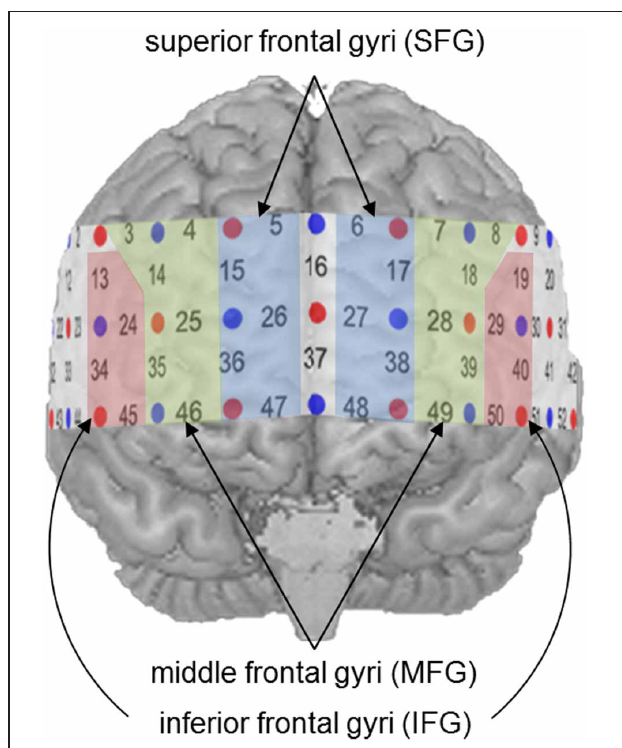
FIGURE 3 | Defined regions of interest (ROIs).